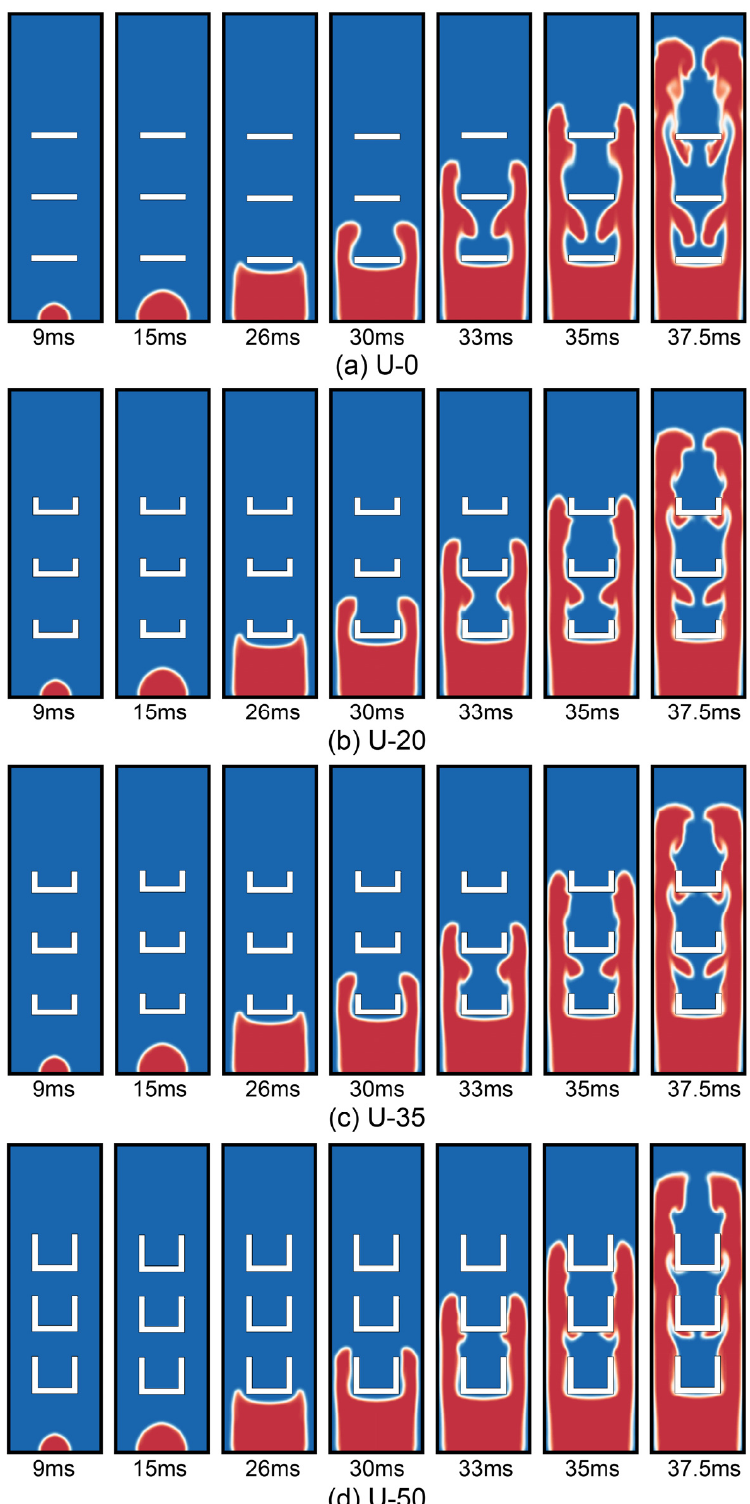
Figure 5. The flame propagation progress: ( a ) U-0; ( b ) U-20; ( c ) U-35; ( d ) U-50.